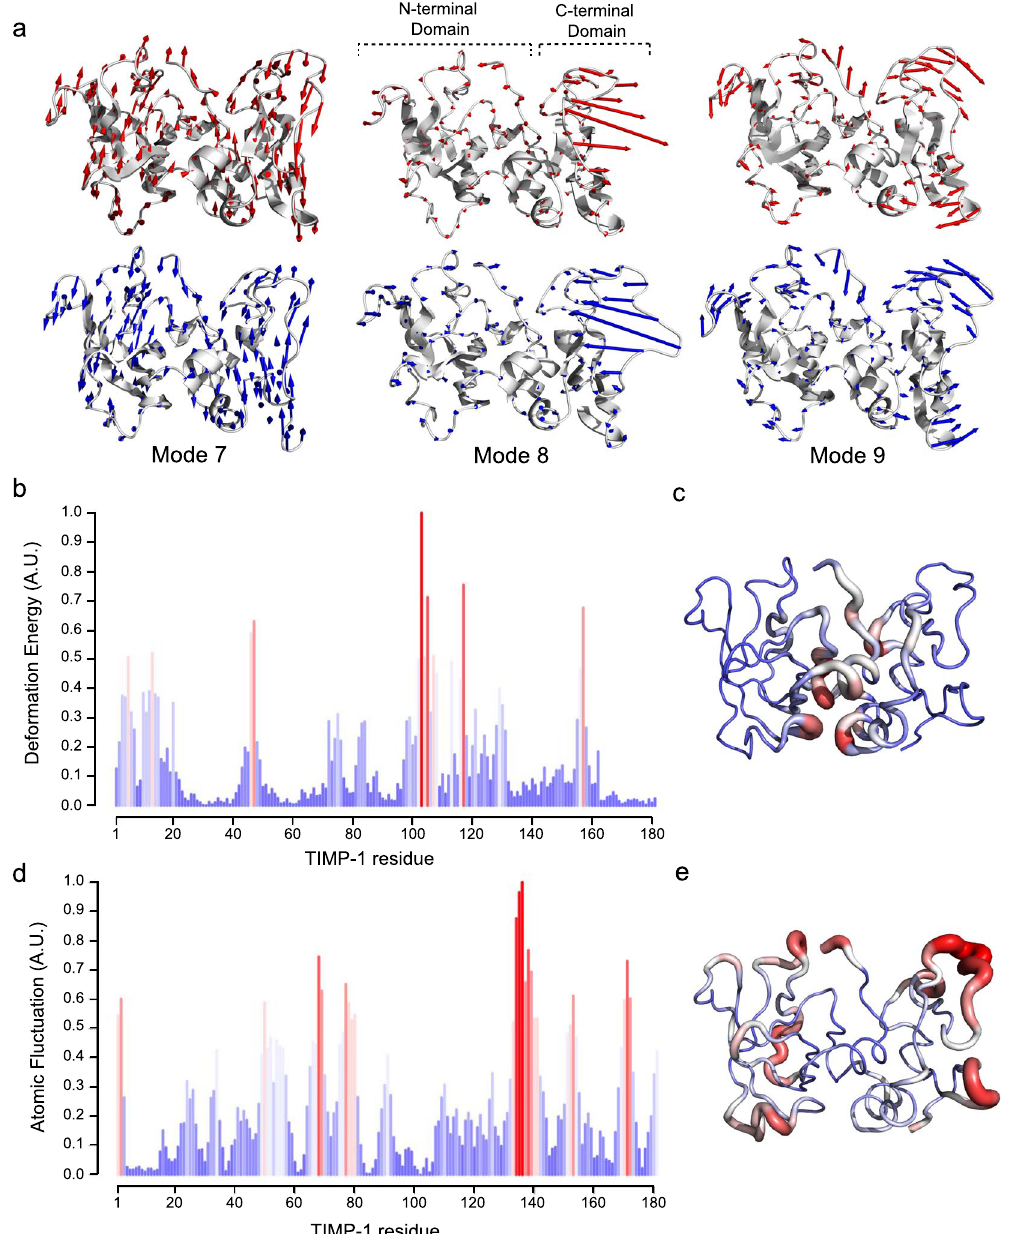
Figure 1. Normal mode analysis of TIMP-1 structure. ( a ) Intrinsic dynamic of TIMP-1 along modes 7, 8 and 9. Open structures of TIMP-1 are in the upper part of the panel and closed structures are in the lower part. Arrows (blue and red) indicate the direction and the deviation (length of arrows) of each residue returning to the 3D reference structure of TIMP-1. ( b ) Deformation energy of each TIMP-1 residue (numbering of the mature secreted protein) along mode 7. The lowest deformation energies are coloured blue and the highest are red. ( c ) Visualisation of the TIMP-1 3D-structure of each amino acid deformation energy. Residues with the lowest deformation energy are thin and coloured blue and those with the highest atomic fluctuation are thick and coloured red. ( d ) C α atomic fluctuation of each TIMP-1 residue (numbering of the mature secreted protein) along mode 7. The lowest atomic fluctuations are coloured blue and the highest are red. ( e ) Visualisation of the TIMP-1 3D-structure of each amino acid atomic fluctuation. Residues with the lowest atomic fluctuations are thin and coloured blue and those with the highest atomic fluctuations are thick and coloured